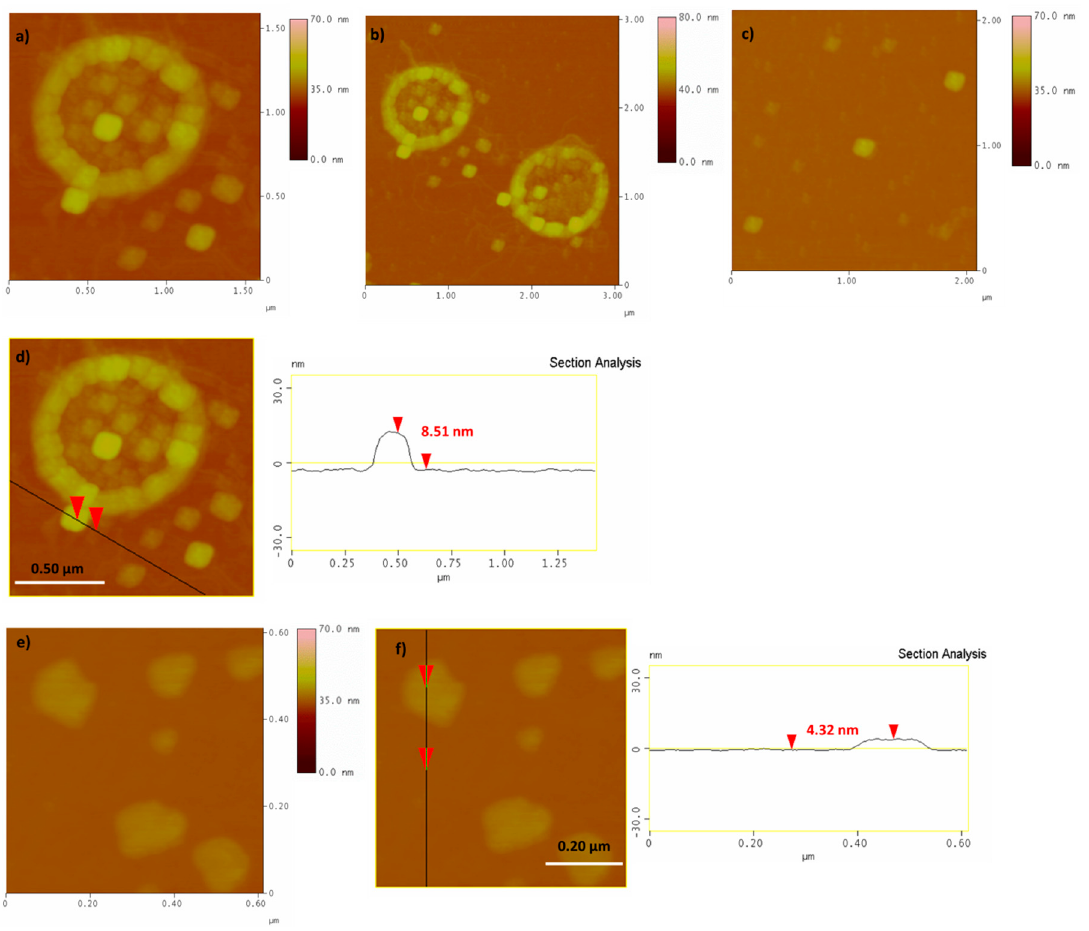
Figure 3. Atomic force microscopy (AFM) height images and cross section analysis of PCC ( a – d images) and PCCox ( e – f images).